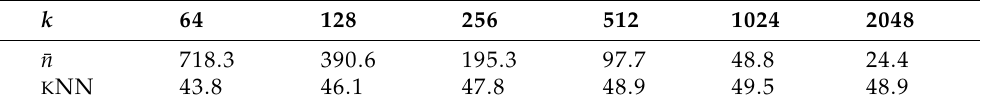
Table 15. CIFAR-100: Evaluations for different k .